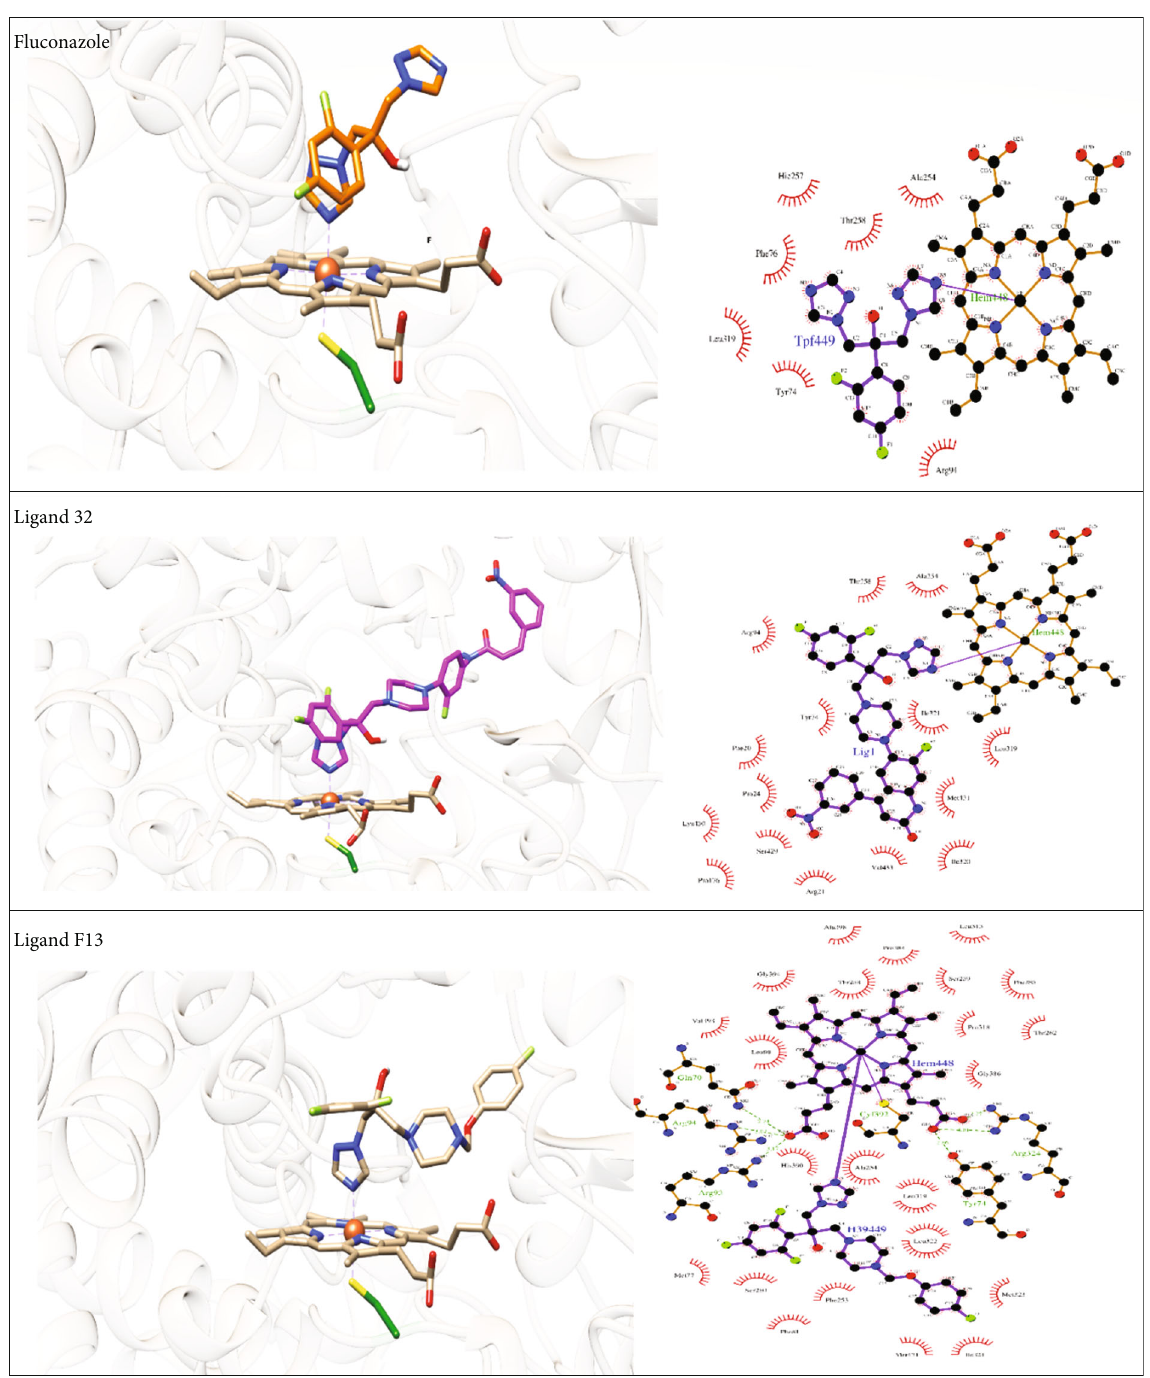
Figure 8: Binding site of the fl uconazole, 32, and F13 ligands to protein (as two-dimensional and three-dimensional images after